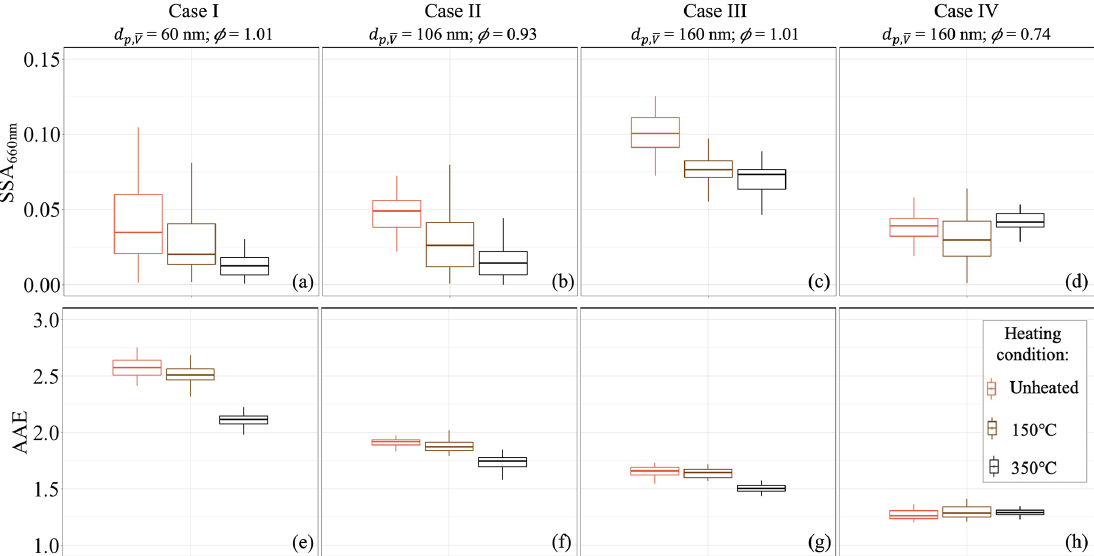
Figure 3. Measured optical properties for the four cases of experiment E1. Panels (a) – (d) show single-scattering albedo (SSA), and pan- els (e) – (h) show Ångström absorption exponent (AAE). In each panel, the boxplots are arranged for three heating conditions where the BC particles bypass the catalytic stripper (unheated) or pass through the catalytic stripper operated at 150 or 350 ◦ C, respectively. The operating condition is indicated in the legend on the top right of the